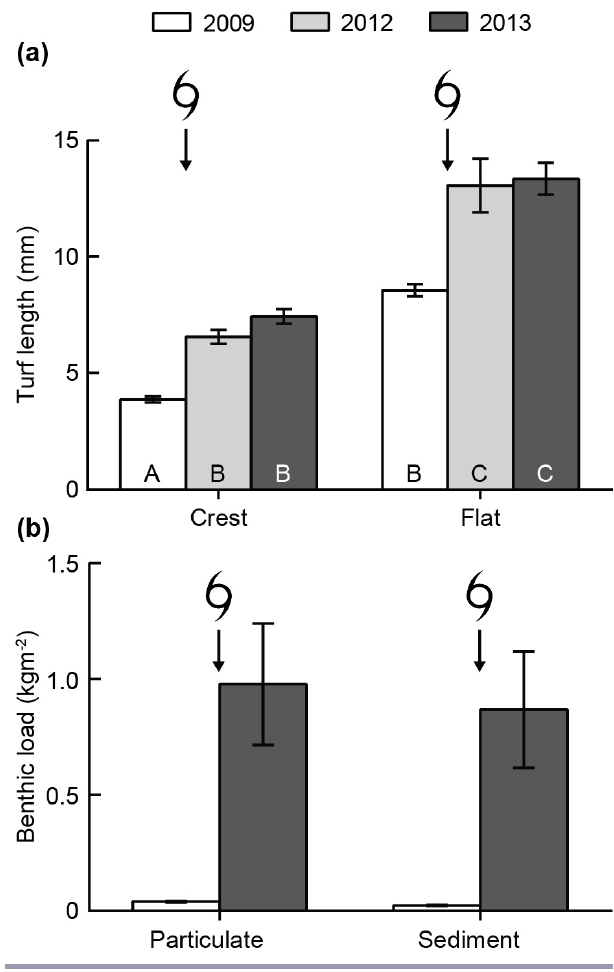
Fig. 3 . (a) The length of algal turf filaments on the reef crest and flat of Pioneer Bay in 2009, 2012, and 2013, respectively. Cyclone Yasi was in 2011. Letters in bars indicate